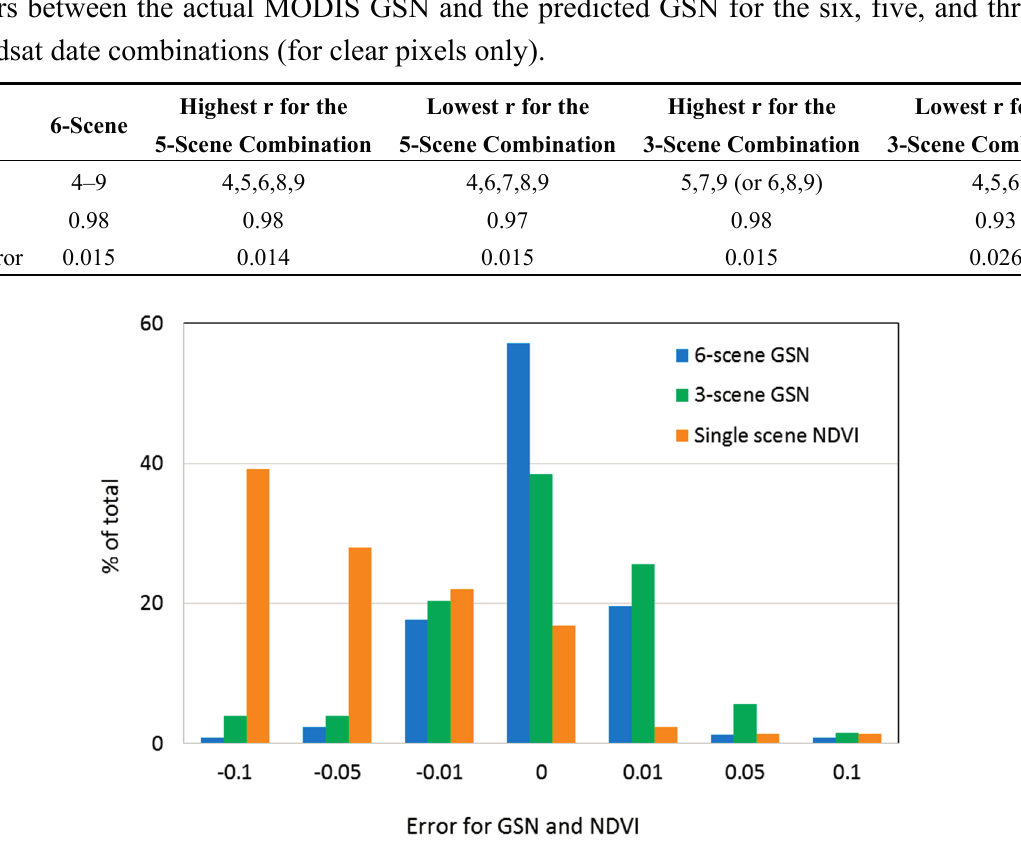
Figure 4. Error (difference between the predicted GSN and the actual MODIS GSN) histograms (% of total) for the “6-scene” (blue) and the “3-scene, April-May-June” (green). Histogram with “orange” color represents the differences between the upscaled LANDSAT NDVI and the 250-m MODIS NDVI for a single scene. Discussion on the “Orange” histogram can be found in the “Discussions”